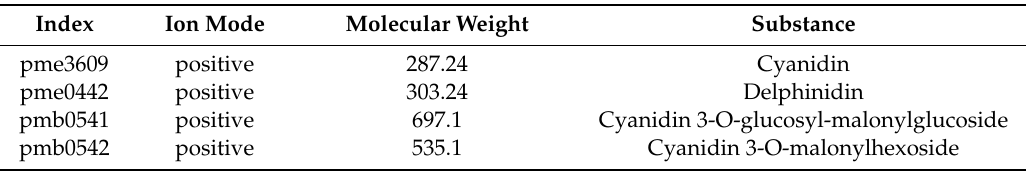
Table 3. Anthocyanin content of petal in P. limprichtii